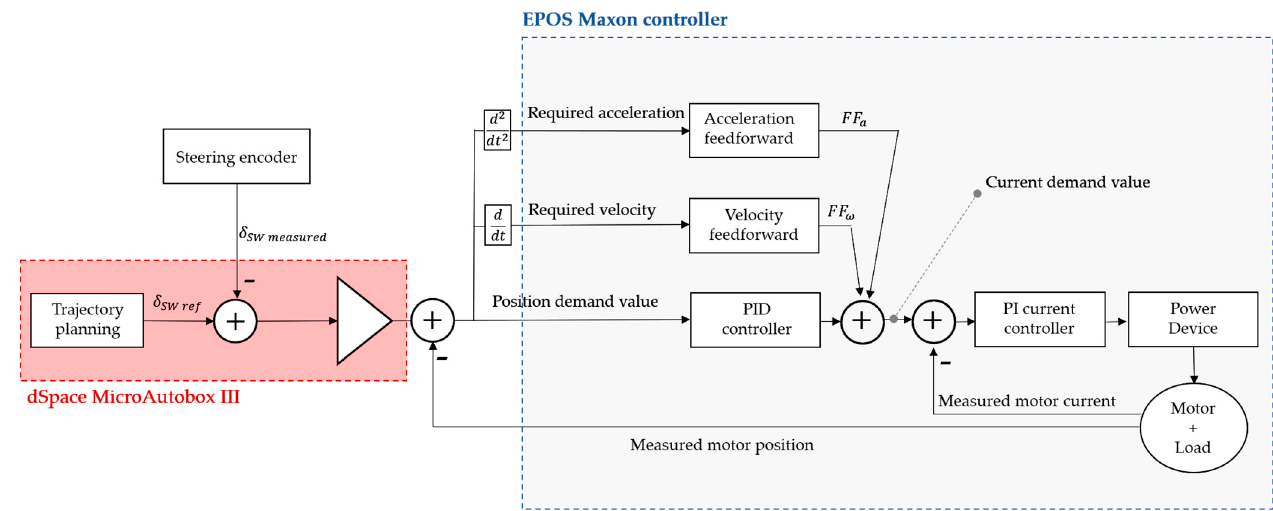
Figure 4. Electric motor control block diagram.